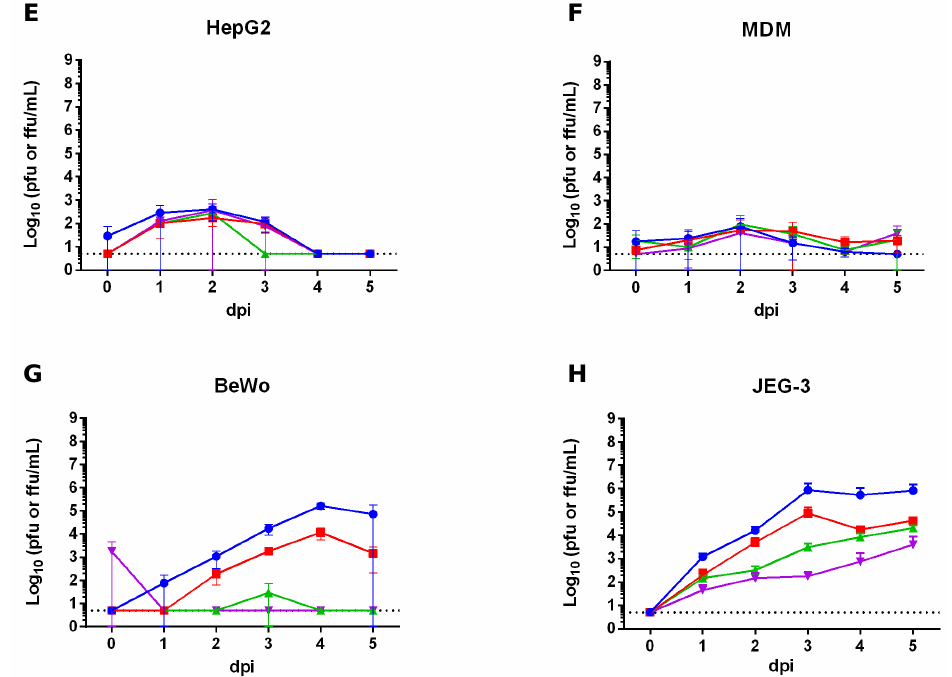
Figure 5. Characterization of reporter-carrying viruses in di ff erent cell lines. ( A ) Various cell lines of primate, human, and mosquito origin and human primary monocyte derived macrophages (MDM) were infected with nLuc-50C / FrSh in duplicates at an MOI of 0.01 in 24-well plates. Luciferase activity in cell lysates was measured daily for five days. ( B – H ) Growth kinetics of nLuc-50C / FrSh, GFPc-50C / FrSh, parental Paraiba_01 / 2015, and recombinant ZIKV-ICD viruses (colors representing each virus are defined in panel B ) in Vero ( B ), C6 / 36 ( C ), LLC-MK2 ( D ), HepG2 ( E ), MDM ( F ), BeWo ( G ), JEG-3 ( H ). Cells were infected with each virus at a MOI of 0.01 in 12.5 cm 2 flasks in duplicates. Aliquots were taken every day for five days after infection, and FFA or PFA was performed to determine virus titers. Results are presented as mean values of two biological replicates with SD shown as error bars. Dotted line represents limit of detection of the assay (0.7 Log 10 (pfu or ff u /